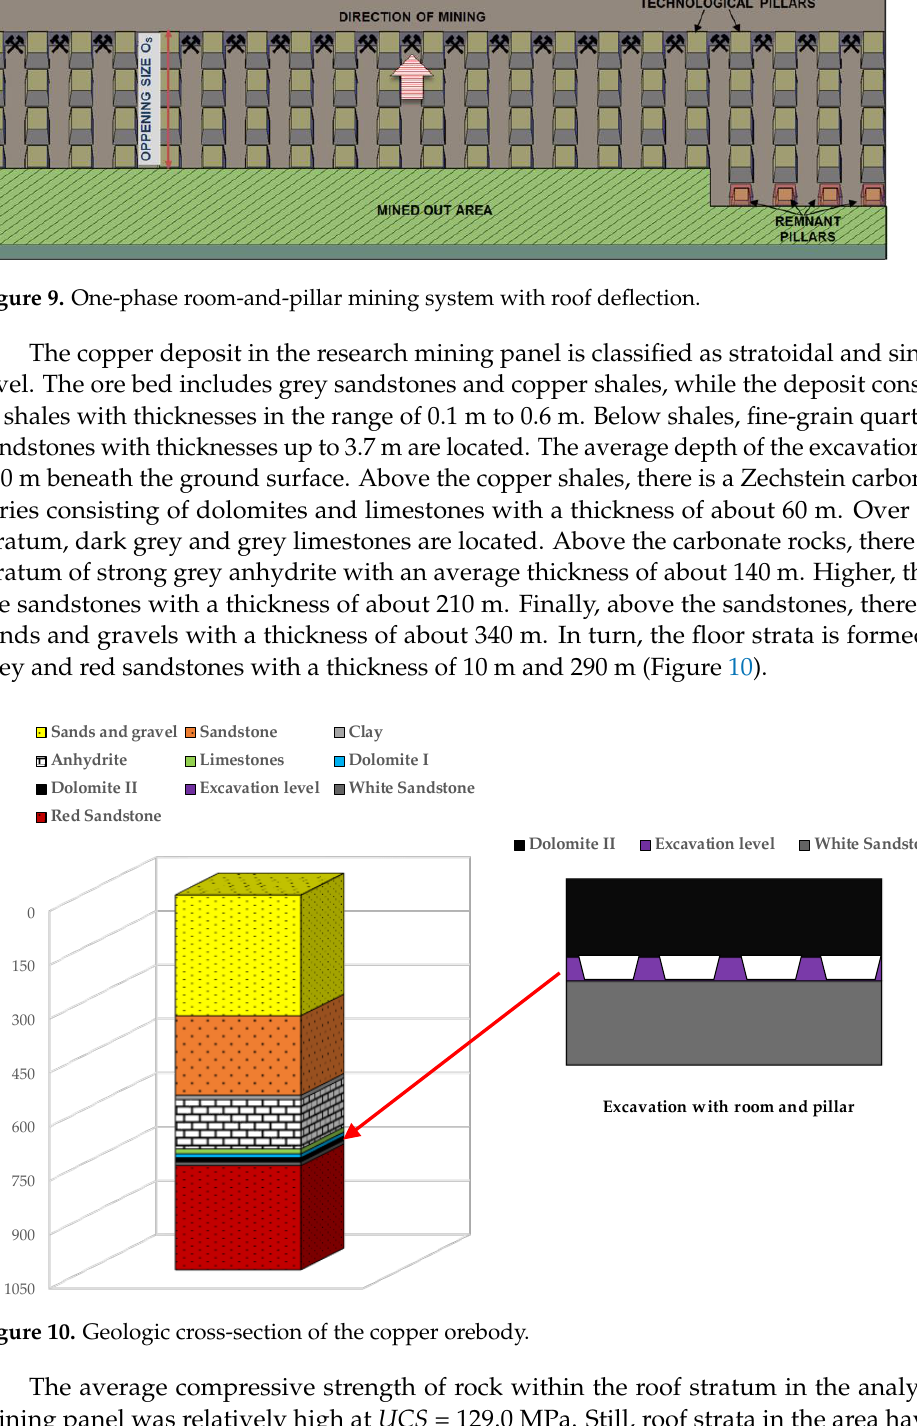
Figure 11. Map of the mining panel with stages of the operation ’s progress. Results of Pilot Measurements